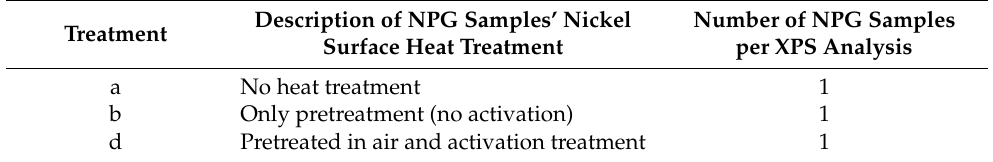
Table 3. Test Matrix for XPS analysis of NPG